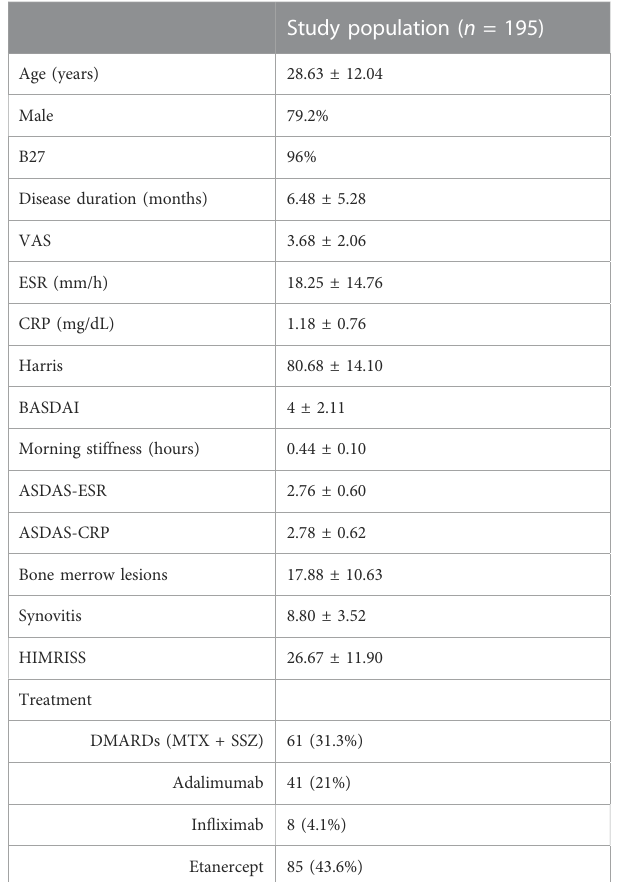
TABLE1Demographic,clinical,laboratory,andMRIcharacteristicsofthestudy population. VAS, visual analogue scale; ESR, erythrocyte sediment rate; CRP, C-reactive protein; BASDAI, Bath Ankylosing Spondylitis Disease Activity Index;ASDAS,AnkylosingSpondylitis DiseaseActivityScore;DMARD:Disease- modifying anti-rheumatic drug; MTX, sulfasalazine; SSZ, Sulfasalazine.